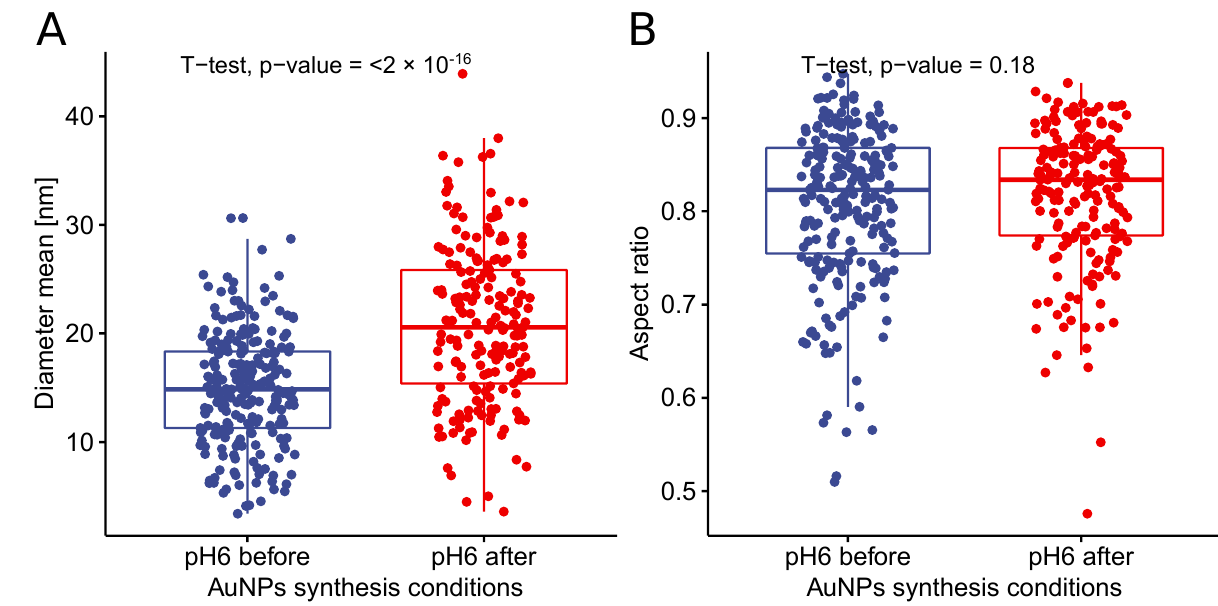
Figure 12. Blue dots correspond to the nanoparticles that had a pH value that was adjusted before AuNP preparation, and the red dots correspond to nanoparticles that had a pH value that was adjusted after AuNP preparation. ( A ) The mean diameter of AuNPs prepared at pH 6; ( B ) the aspect ratio of AuNPs prepared at pH